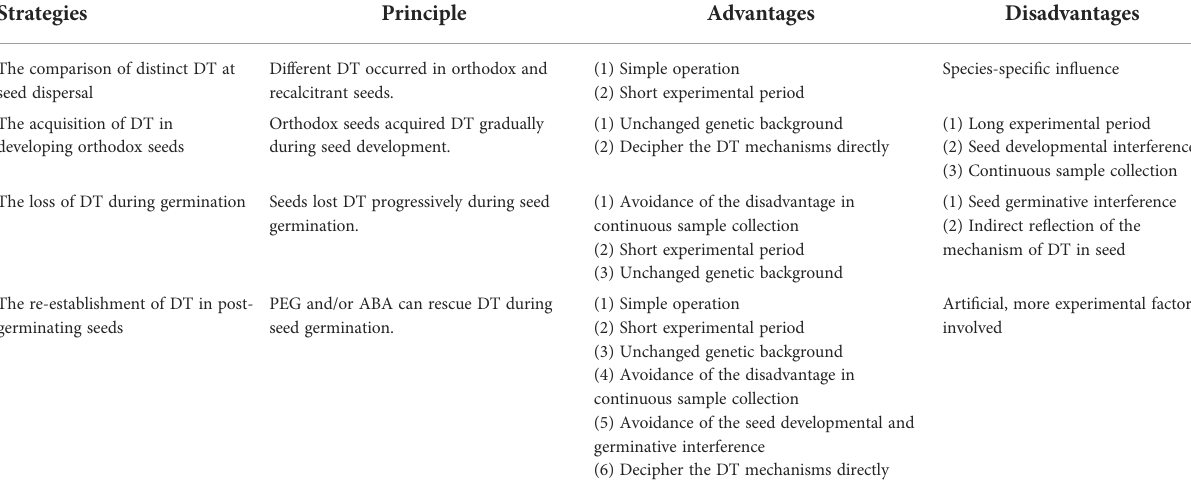
TABLE 1 Principle, advantages, and disadvantages of strategies for studying the mechanism of DT in seeds.